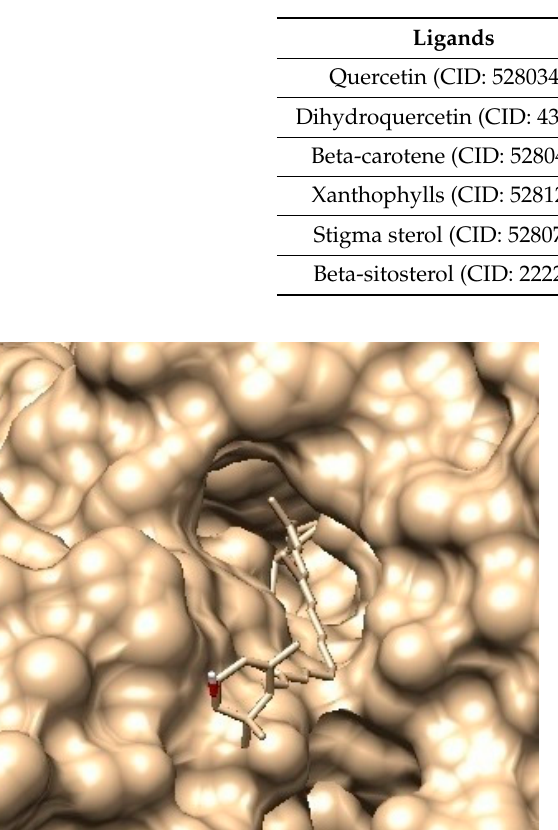
Table 5. Initial docking by iGEMDOCK.